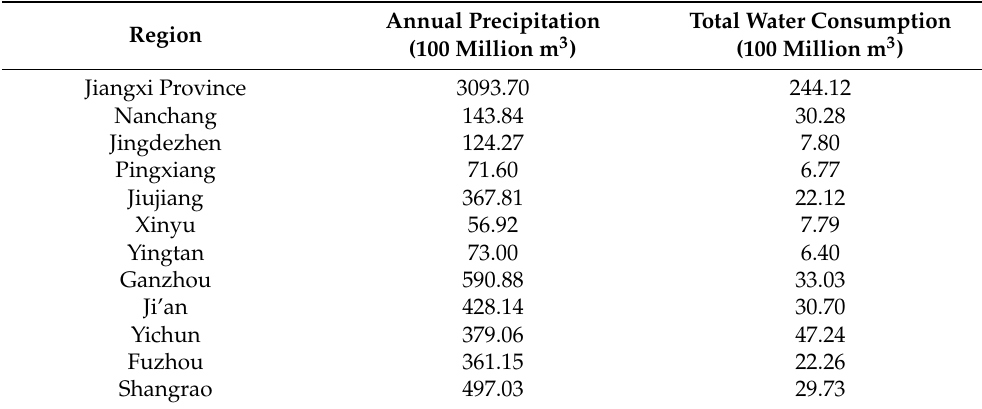
Table 1. Annual precipitation and total water consumption of Jiangxi Province in 2020.